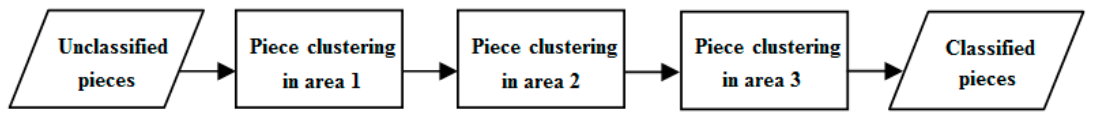
Figure 9. System flowchart of the piece clustering algorithm.